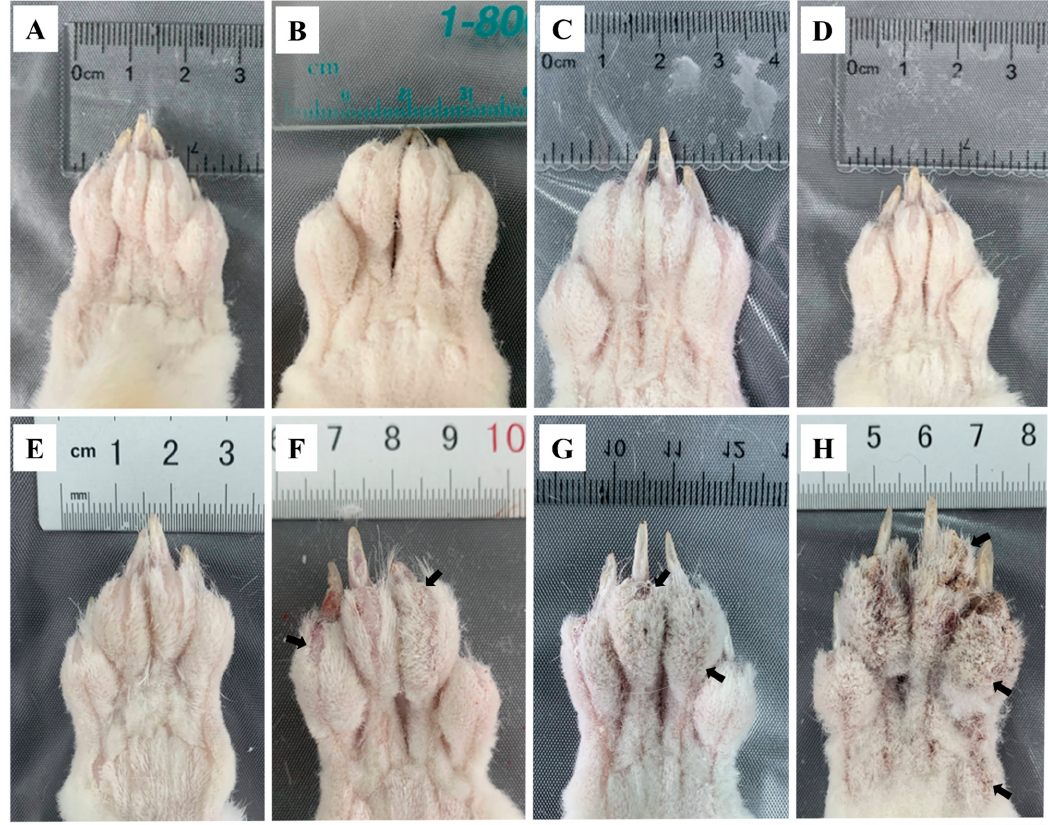
Figure 1. Clinical changes in rabbits infested with S. scabiei (A): control, (B): 6 hpi, (C): 12 hpi, (D): 1 dpi, (E): 3 dpi, (F): 1 wpi, (G): 4 wpi, (H): 8 wpi. Arrows point to the